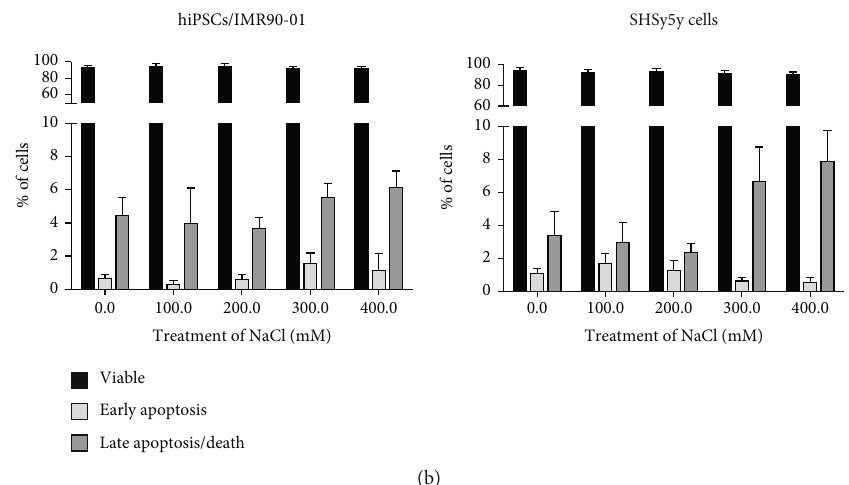
Figure 3: The fl ow cytometric (FACS) analysis diagram of NaCl for hiPSCs/IMR90-1 and SH-SY5Y. (a) Representative fl ow cytometric multicolor gating of cells used to analyze the number of live/dead cells and representative pro fi les of FACS analysis after 1-hour treatment with NaCl. Cells were collected after 1-hour treatment with di ff erent concentrations of NaCl, stained with Annexin V and PI, and analyzed by FACS. Cells without NaCl treatment were used as negative controls ( n = 4 in each group). The diagram can be divided into four regions that are de fi ned as follows: the percentage of necrotic cells (Q1; PI/FITC +/ − ), the percentage of late apoptotic cells (Q2; PI/FITC +/+), the percentage of viable cells (Q3; PI/FITC − / − ), and the percentage of early apoptotic cells (Q4; PI/FITC − /+). (b) Percentages of viable, early, and late apoptosis are presented in the graphs for both types of cells. Results represent four independent experiments with similar